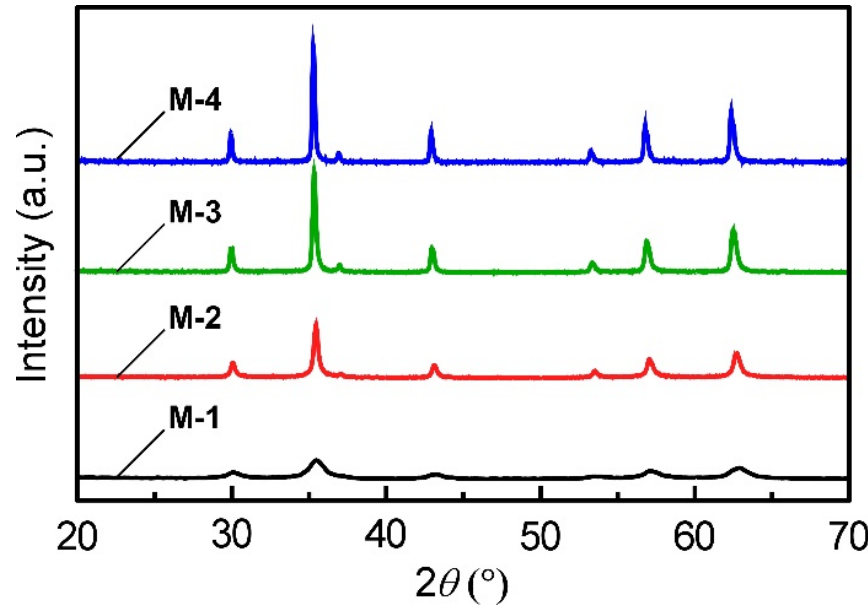
Figure 1. XRD patterns of the magnetite microparticles of M1 – M4 with different diameters prepared by the hydrothermal synthesis.